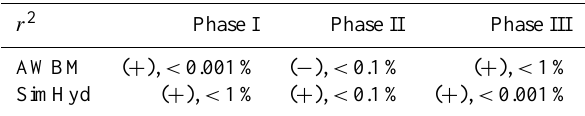
Figure 5. The relationship between model residuals (modelled and observed daily flows) and peak hourly rainfall intensity for Phase 2 (August 1990–July 1994) using SimHyd. Table 3. The sign and strength of correlation ( r 2 ) between the peak hourly rainfall intensity (mmh − 1 ) and the difference between mod- elled and observed daily flows (mm) for the Rimbaud watershed in